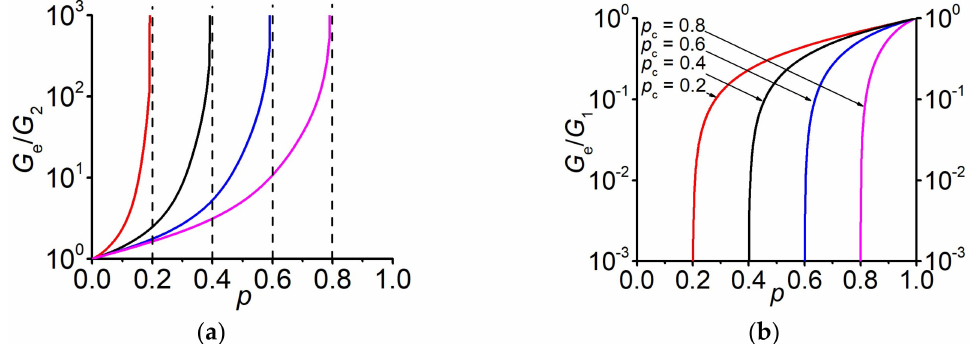
= 0 for various values 1